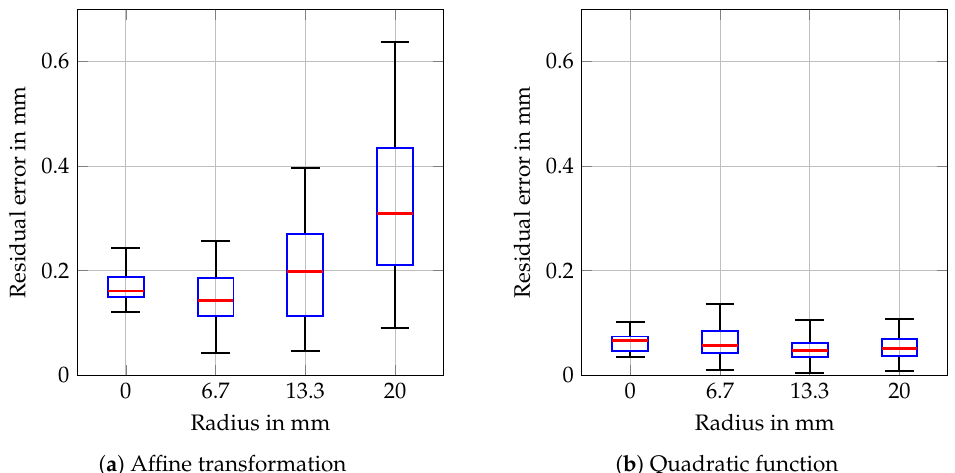
Figure 7. Boxplots of the residual calibration errors after fitting only an affine transformation ( a ) and after additionally fitting a quadratic function ( b ) depending on the radius within the cylindrical volume of the positions. The red bars indicate the medians, the blue boxes range from the 25%-quantiles to the 75%-quantiles, and the whiskers cover all data